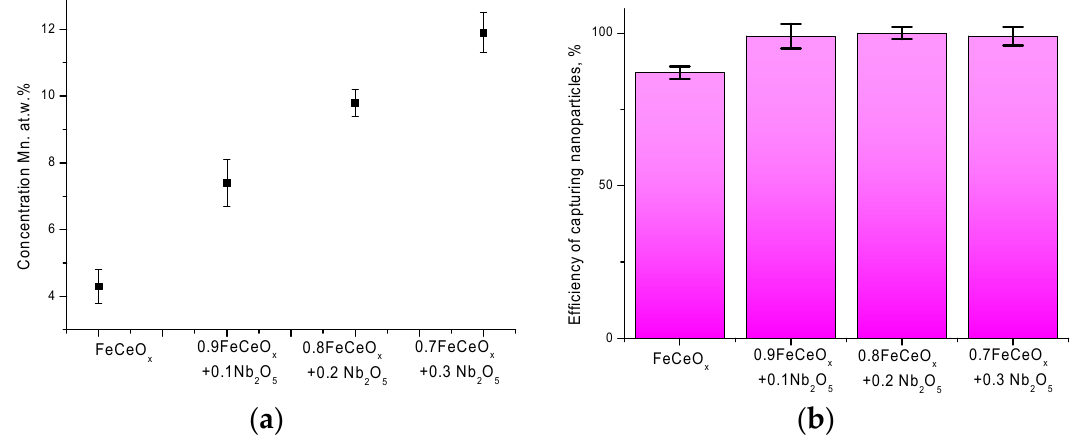
Figure 15. Data of energy dispersion analysis and conservation of mass of nanoparticle samples after filtration: ( a ) graph of changes in the concentration of manganese on the surface of nanoparticles after filtration; ( b ) graph of the efficiency of capturing nanoparticles after filtration.